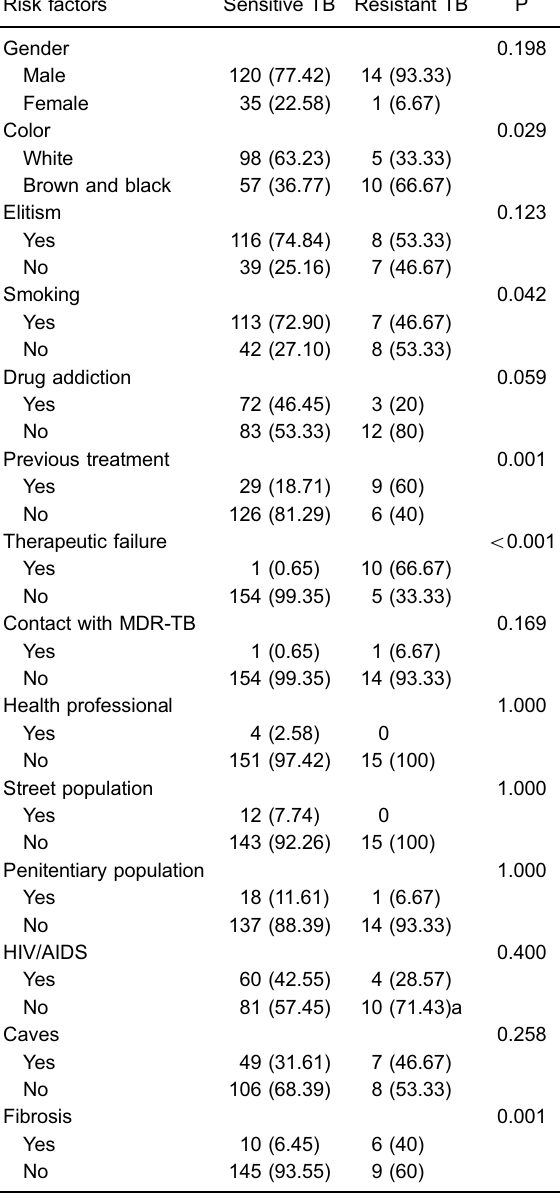
Table 1. Analysis of the association between variables studied and the development of resistance to tuberculostatic drugs (rifampicin, isoniazid or